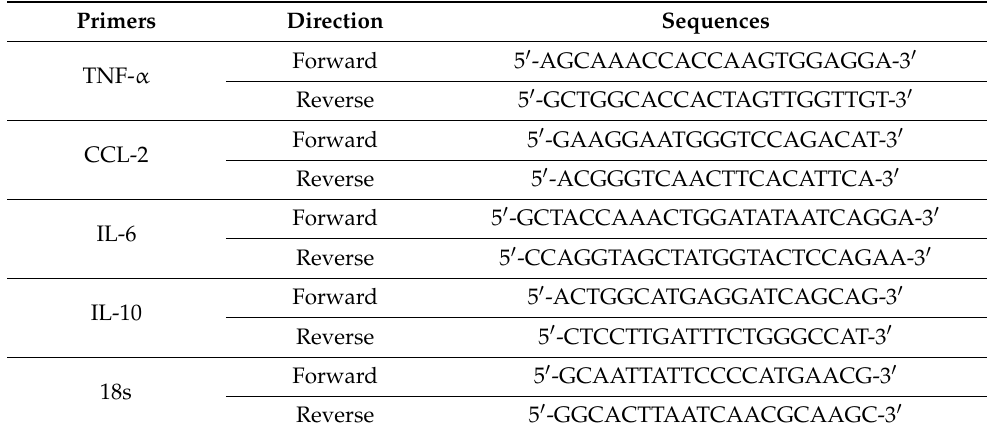
Table 1. Primer sequences for the genes of interest and reference